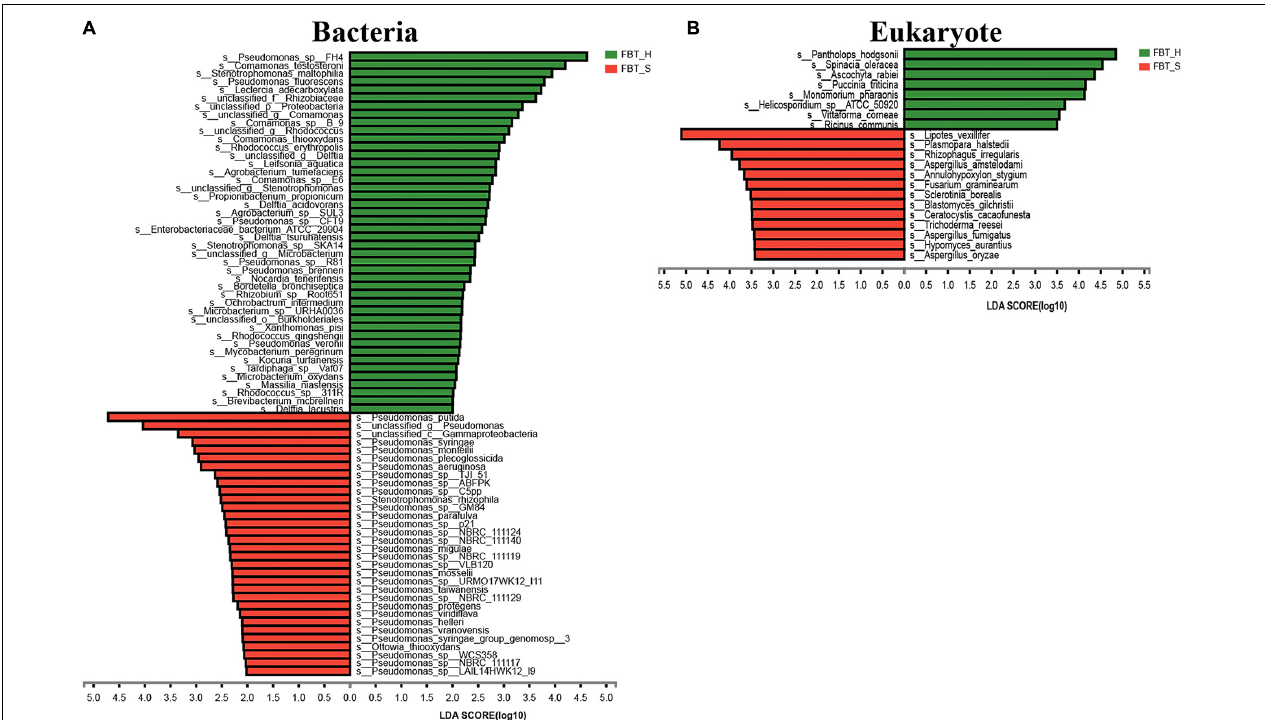
FIGURE 2 | LEfSe analysis of (A) bacterial and (B) eukaryal populations that differed between FBT_H and FBT_S samples based on linear discriminant analysis (LDA) scores. Higher LDA scores indicate greater differential effects of samples on species abundances.